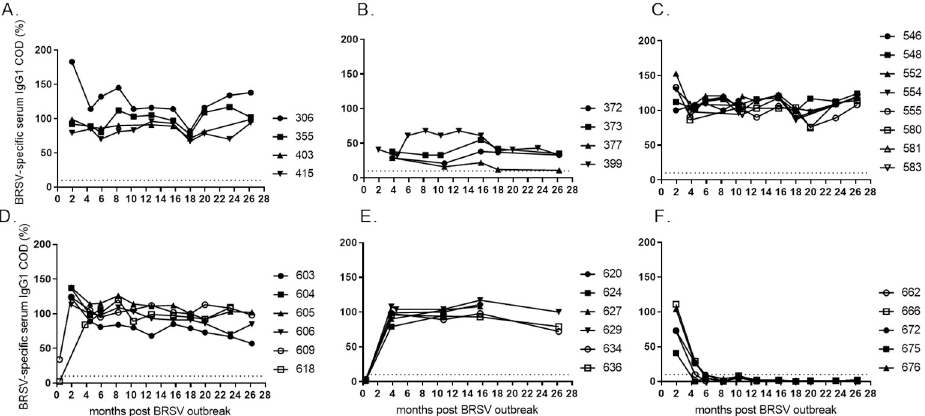
Fig 3. Kinetics of BRSV-specific serum IgG1 in cattle of different age and production status. At the time of a BRSV outbreak the cattle were (A) 23–30 months old ( < 6 months gestation), (B) 24–26 months old ( > 6.5 months